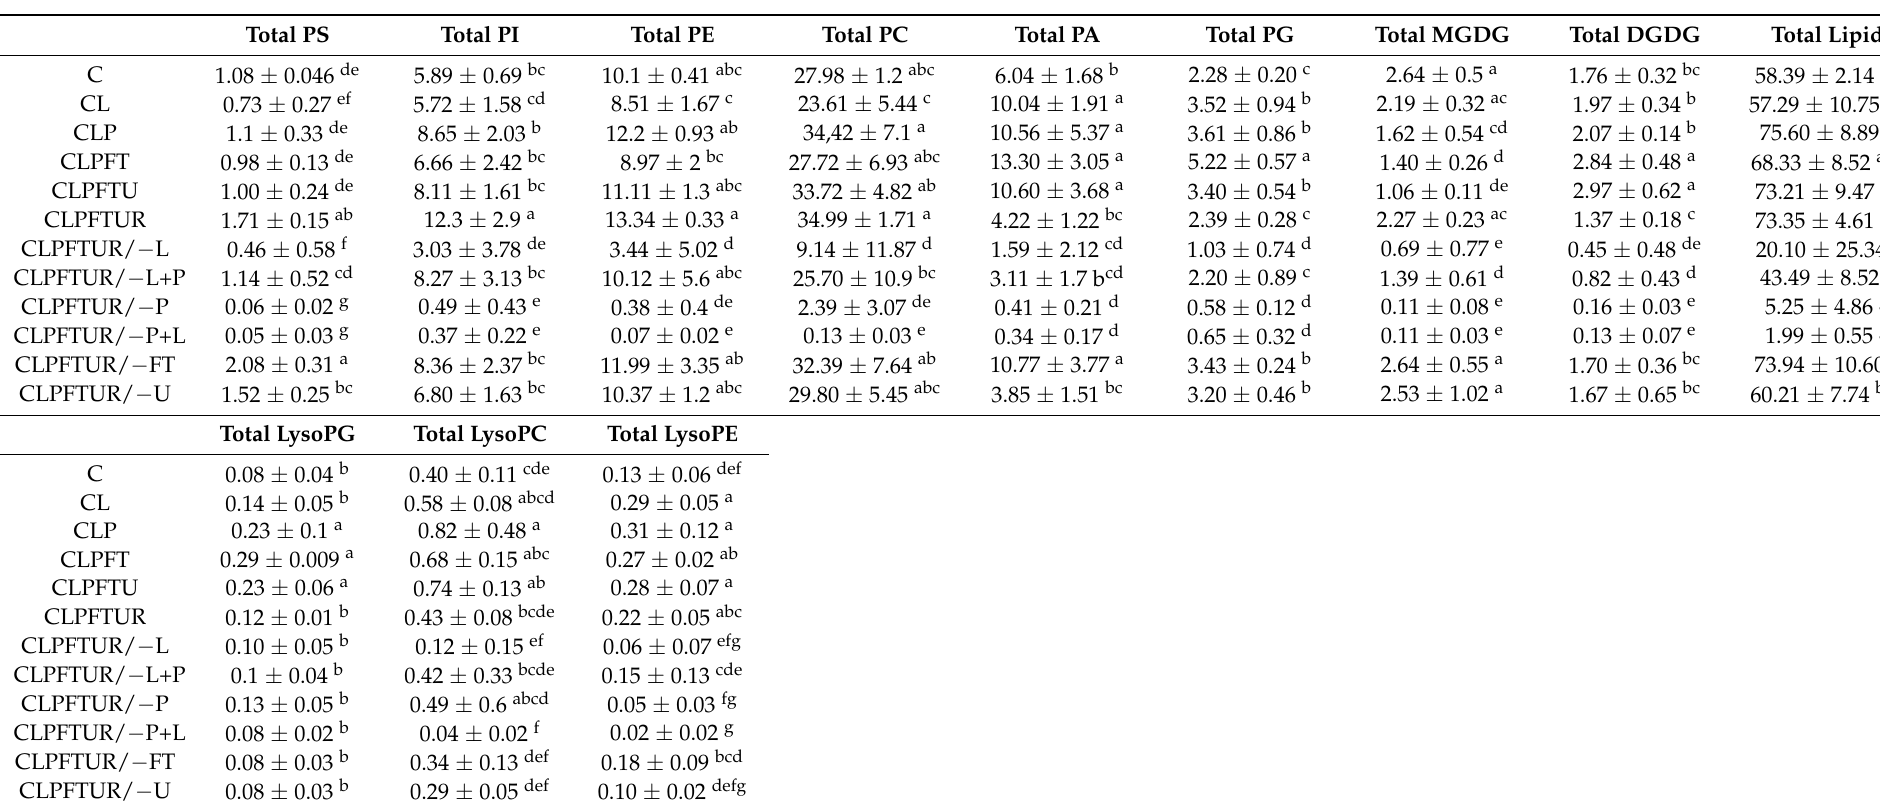
Table 1. Total amount of lipid (nmol/mg dry weight) in each head-group class in Magnolia officinalis ECs after various cryogenic treatments. Values in the same column marked with different letters are significantly different ( p < 0.05). Values are means ± SD ( n =